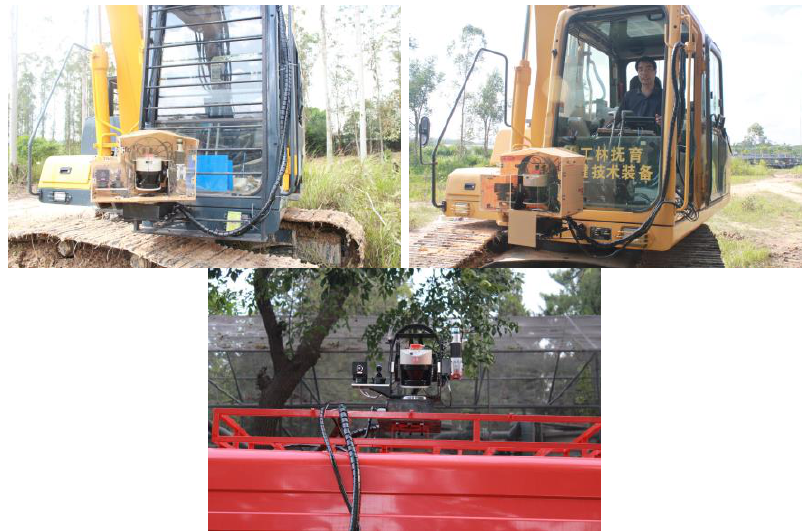
Figure 2. Measuring system installed at different forestry machines for operations experiment.